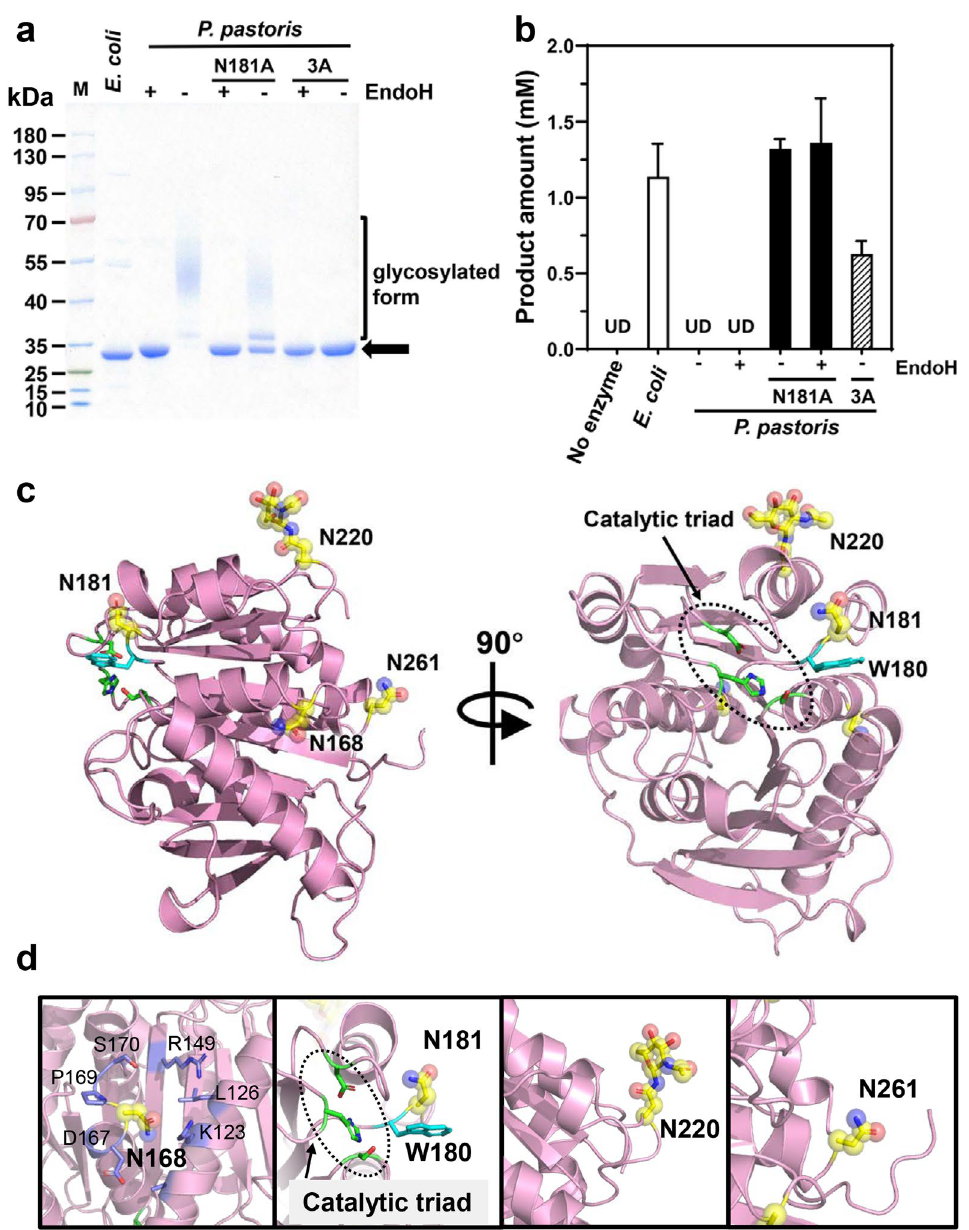
Fig. 2 The effects of N ‑glycosylation on P. pastoris ‑expressed Ct PL‑DM. a SDS‑PAGE analysis of recombinant proteins expressed in E. coli and secreted by P. pastoris with or without EndoH treatment. Lane M: protein marker. The theoretical migration distance of Ct PL‑DM on SDS‑PAGE is indicated by an arrow. b PET hydrolytic activity of Ct PL‑DM and each variant expressed by E. coli and P. pastoris that were treated with or without EndoH. The hydrolytic products (MHET and TPA) released from GfPET film by each enzyme as well as blank control without enzyme were measured at 18 h. A triplicate assay was conducted and the average values standard deviation are presented. UD, undetectable; 3A, N181A/N220A/N261A. ± c Crystal structure of Ct PL‑DM (PDB ID, 8IAN), N ‑glycosylation sites are indicated as yellow sticks and transparency spheres with glycan colored by elements. The catalytic triad residues (black dashed circle) are shown as sticks. d The zoom‑in views of four putative N ‑glycosylation